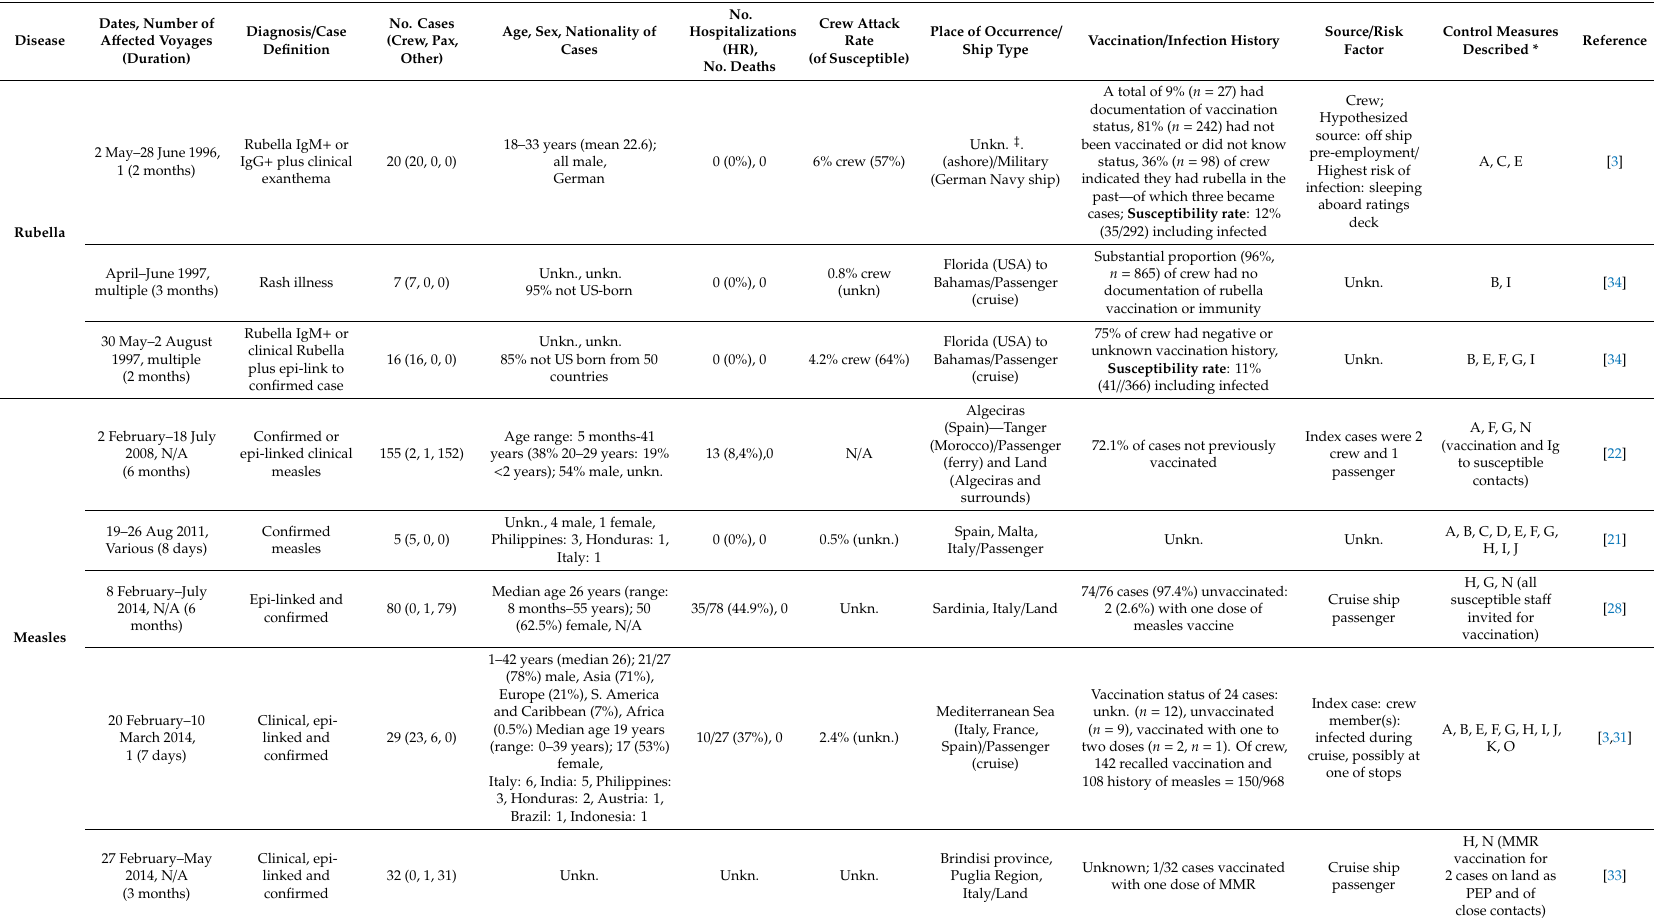
Table 1. Descriptive analysis of outbreak and case reports of vaccine-preventable